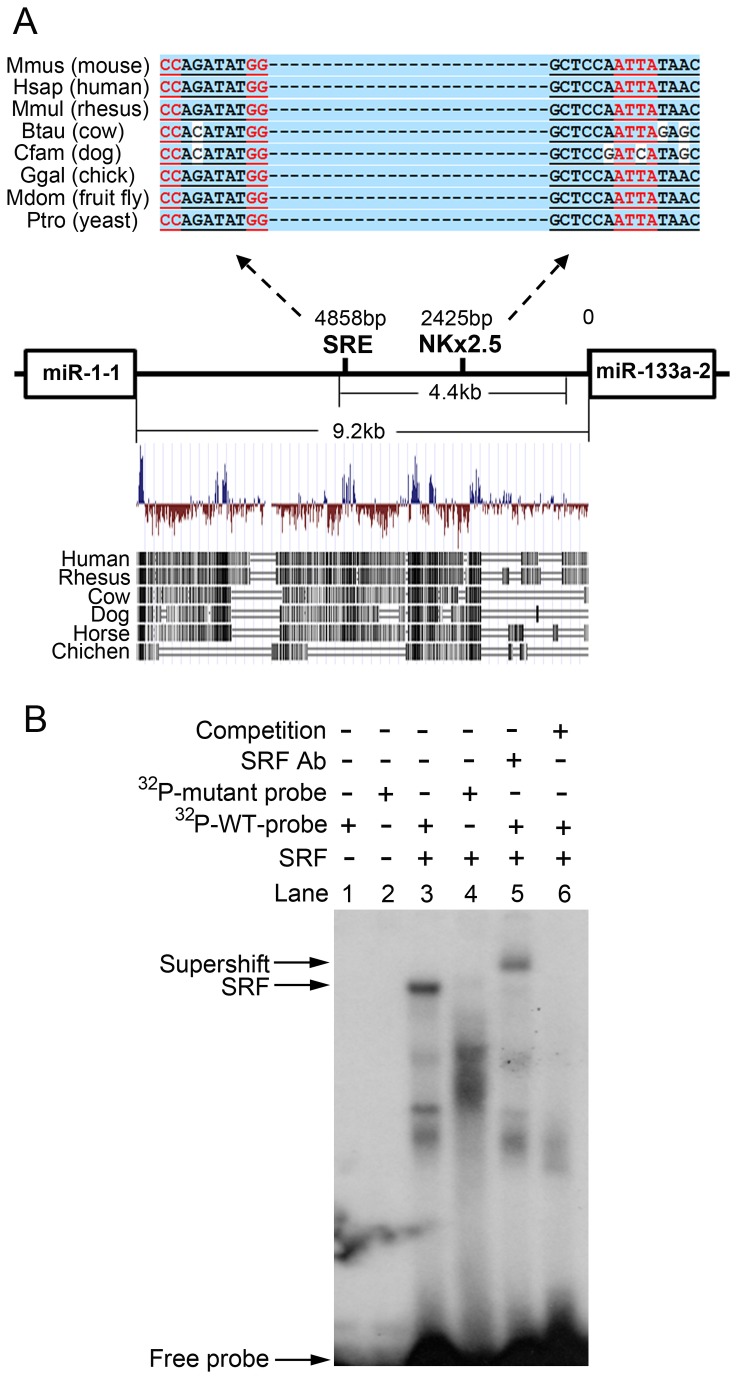
Analysis of miR-1-1/133a-2 intragenic enhancer region.(A) Representative sequence alignments between miR-1-1 and miR-133a-2 genes among species. One putative and highly conserved serum response factor (SRF) binding site (SRE) along with one NK2 homeobox 5 (NKx2.5) binding site were suggested by bioinformatic predictions. (B) A comprehensive electrophoretic mobility shift assay (EMSA) demonstrated specific interaction between SRF and this SRE motif in
vitro. Ab: antibody. WT: wild-type. Competitor: unlabeled WT probe.